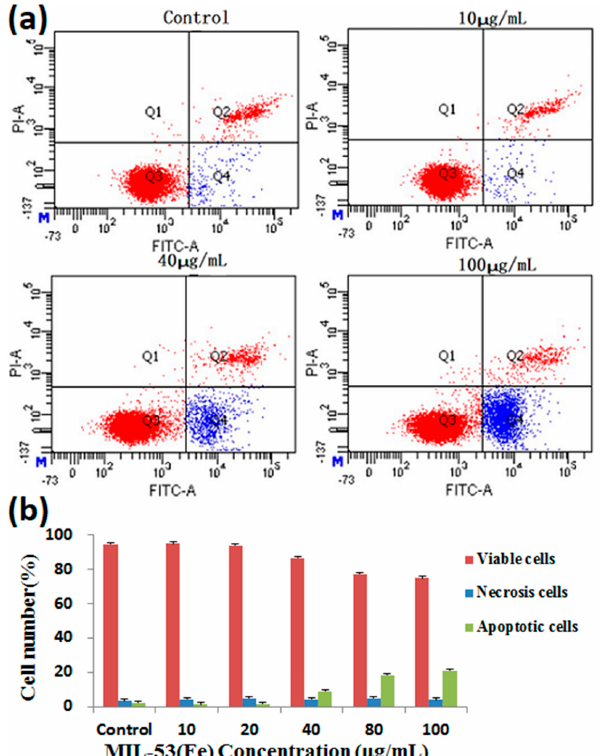
Figure 8. Effects of MIL-53(Fe) on apoptosis in HepG2 cells. ( a ) Flow cytometry detection of apoptosis with FITC-Annexin V/PI double staining. ( b ) The percentages of viable, early apoptosis and late apoptosis of HepG2 cells after incubation with different concentrations of MIL-53(Fe) for 24 h. The data are expressed as means ± S.D. from three independent experiments.